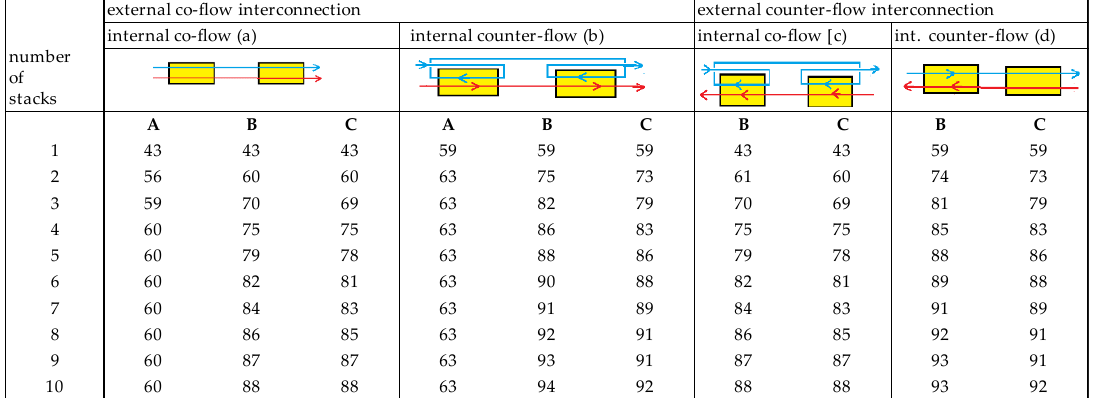
Figure 9. Energy efficiency in percent for the different arrangements of co-flow and counterflow stacks. Three methods for optimization the energy efficiency are listed: with method A successively